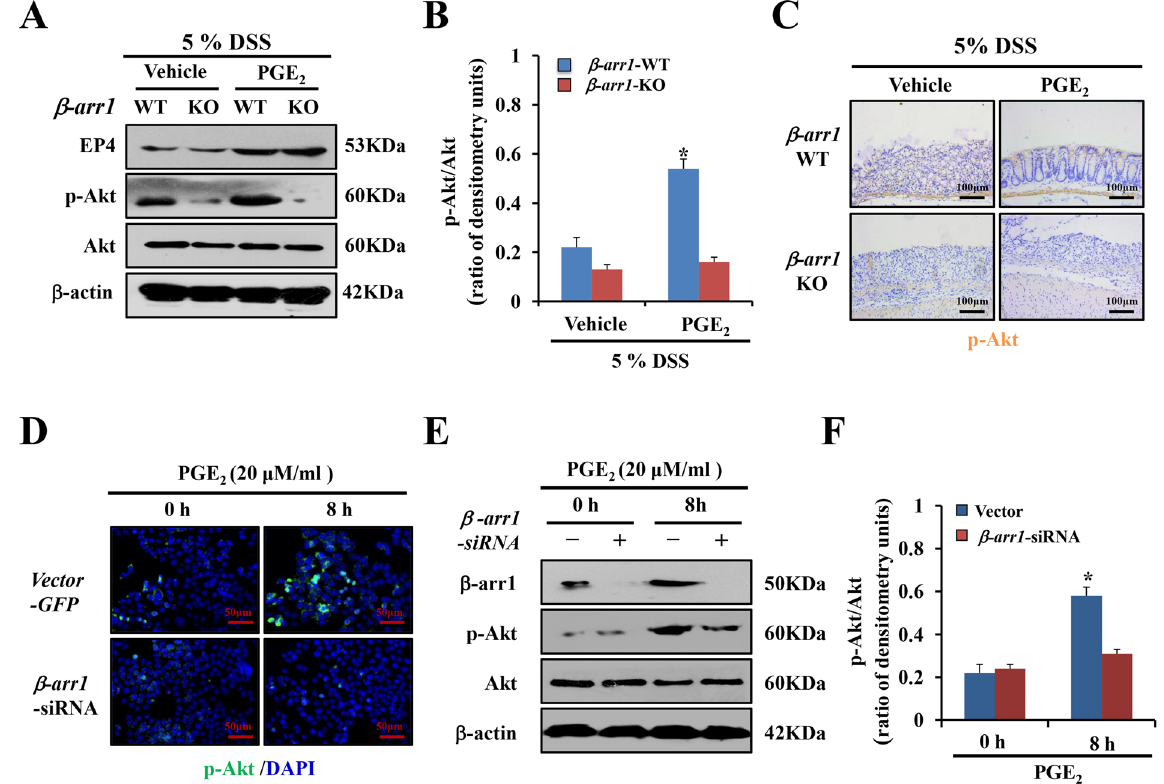
Figure 6. PGE 2 /EP4 upregulates β -arr1 mediated Akt signaling in vivo and in vitro . ( A ) Western blotting of EP4, p-Akt and Akt in colonic mucosa of β -arr1 WT and KO mice treated with DSS with or without PGE 2 at the indicated time points. All western blot images are representative images from three independent experiments, and β -actin was used as a loading control. ( B ) Quantitative analysis of p-Akt/Akt ratio as measured by densitometry scanning of Western blots. Values are expressed as the mean ± SD of three separate experiments, * P < 0.05 versus vehicle. ( C ) Immunohistochemical staining for p-Akt staining in colonic sections of β -arr1 WT and KO littermates under DSS with or without PGE 2 treatment at the indicated time points (brown, × 200, n = 4 per group). ( D ) Expression of p-Akt in HCT116 cells transfected with control or β -arr1 siRNA after PGE 2 treatment. Nuclei were stained with DAPI in blue. Localization of p-Akt was visualized in green. ( E ) HCT116 cells were stimulated with or without PGE 2 (20 μ m/ml) for 8 h in the presence of control siRNA or β -arr1 specific siRNA. The lysates were subjected to Western blotting analysis for β -arr1, p-Akt and Akt. All western blot images are representative images from three independent experiments, and β -actin was used as a loading control. ( F ) Quantitative analysis of the p-Akt/Akt ratio as measured by densitometry scanning of Western blotting. Values are expressed as the mean ± SD of three experiments, * P < 0.05 versus control siRNA